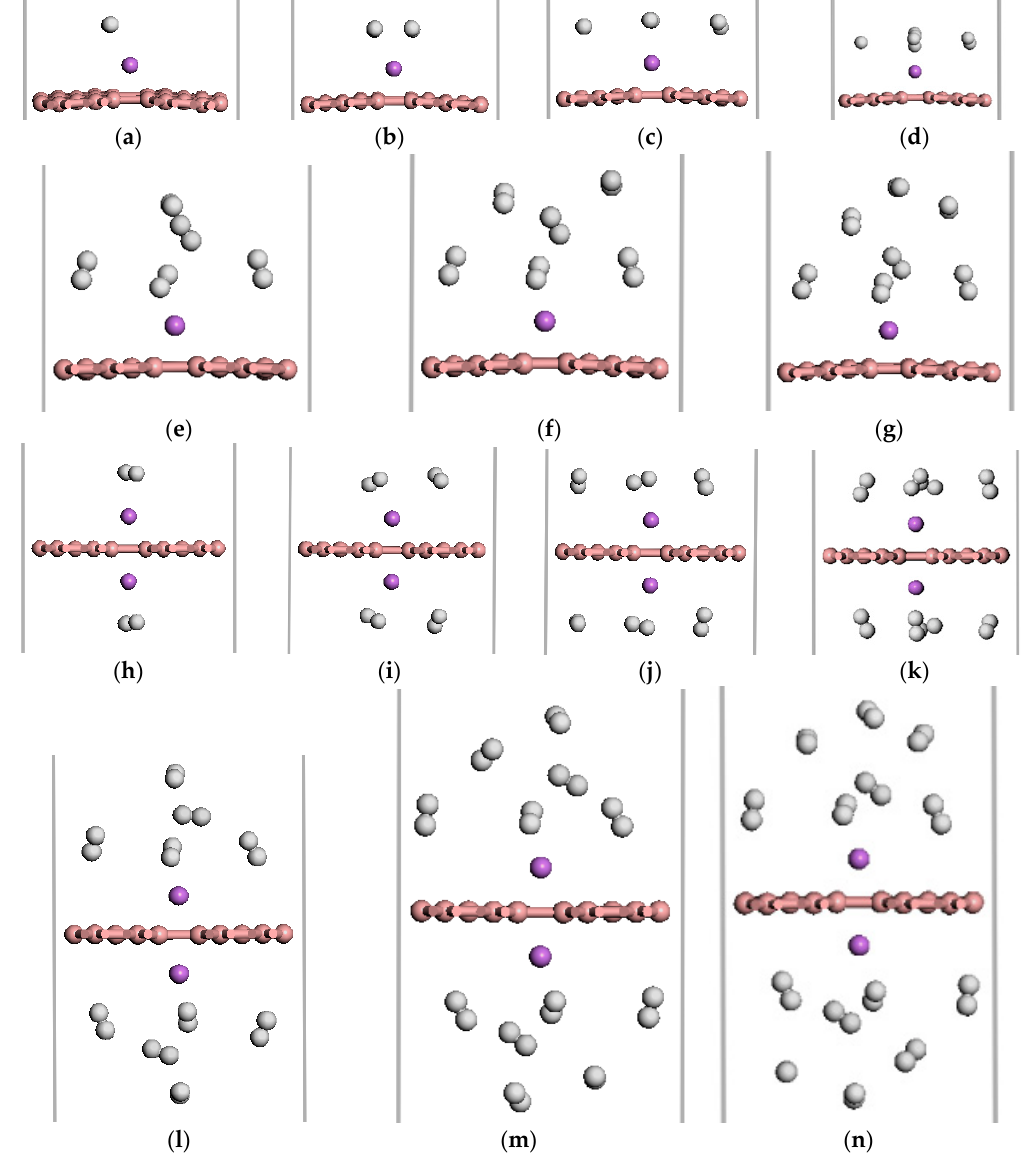
Figure 5. The optimized atomic structures of the Li- β 12 -borophene/H 2 . ( a – g ) are 1~7 H 2 molecules adsorption on Li- β 12 -borophene system. ( h – n ) are 2~14 H 2 molecules adsorption on 2Li- β 12 -borophene system. The pink, purple and white balls in this and aforementioned figures express B, Li and H atoms, respectively.